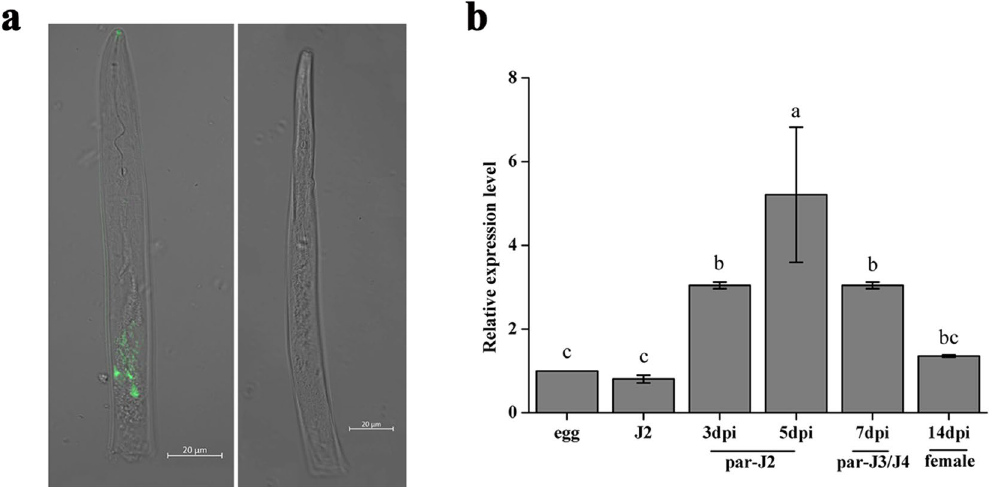
Figure 2. Expression patterns of MgPDI in M . graminicola . ( a ) Localization of MgPDI by in situ hybridization. Right: antisense cDNA probes; left: sense: cDNA probes. ( b ) Expression pattern of MgPDI in five different life stages of M . graminicola . Vertical bars represent the means ± SD.